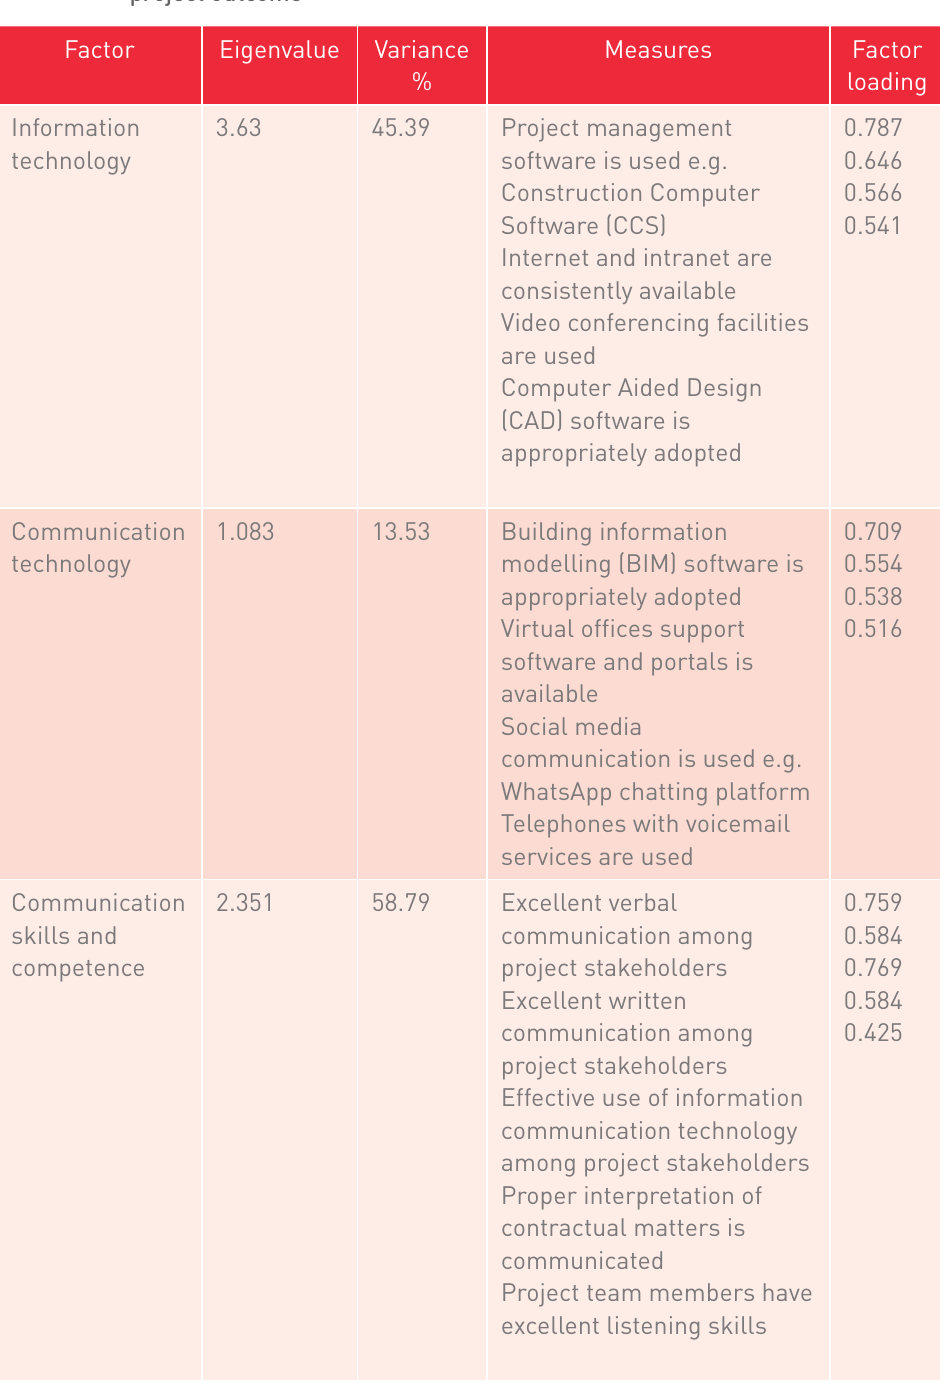
PAF results after rotation of communication management practices and project